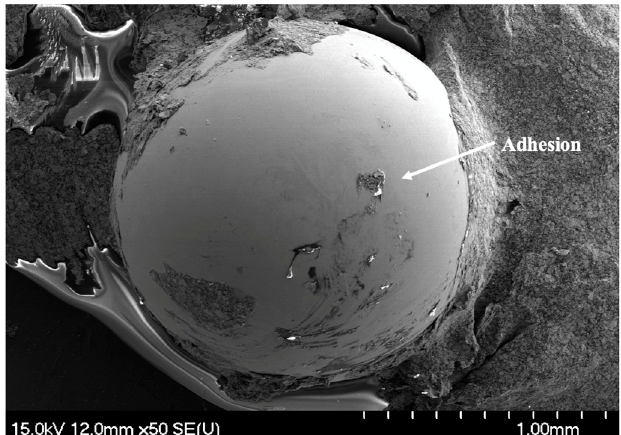
Figure 9. WC ball used to impact as-sputtered coating.